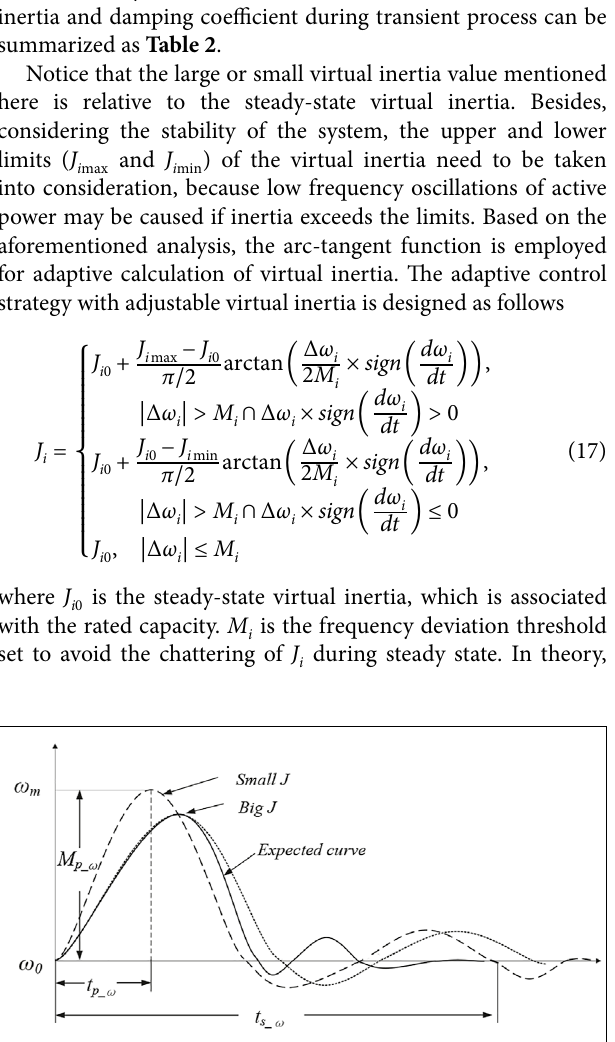
FIGURE 7 | Step response of frequency when J